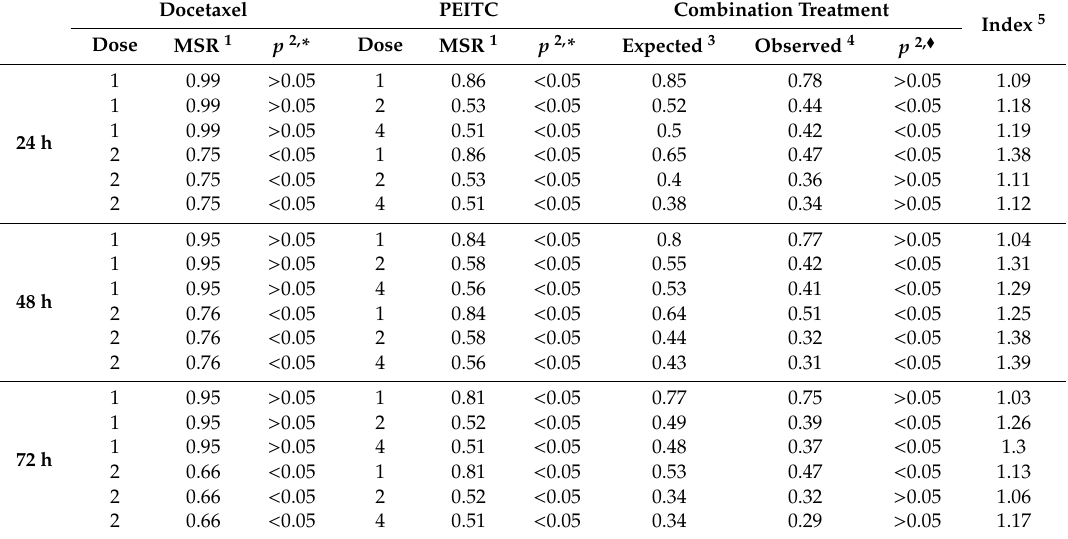
Table A7. Analysis of synergy between PEITC and DOCE calculated by survival rate for PC-3 cells.